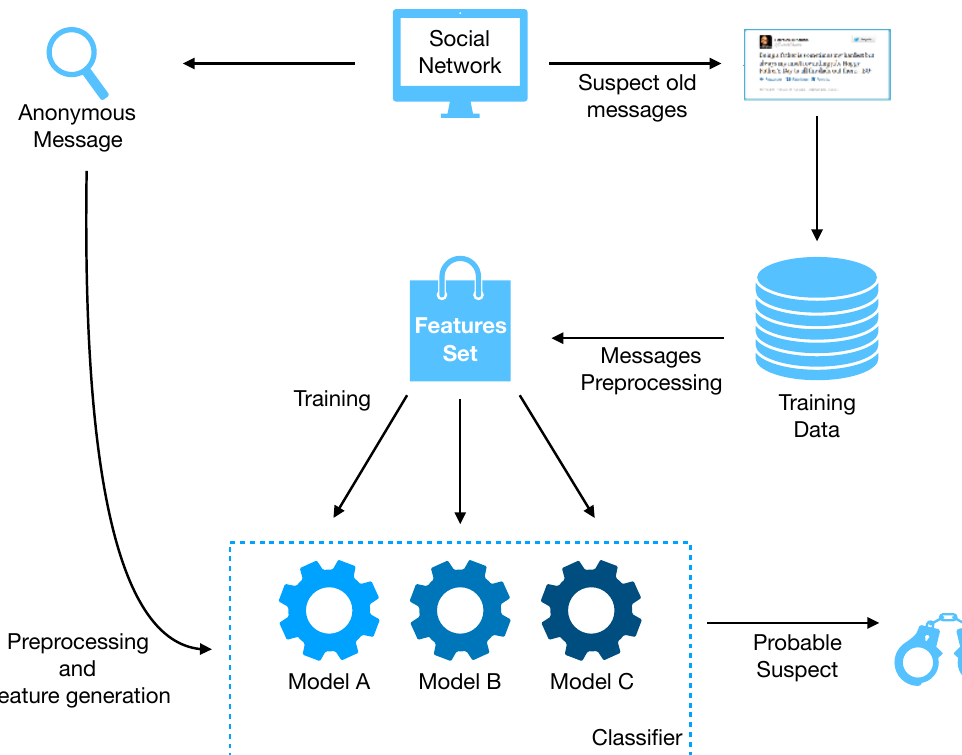
Figure 7 - Overview of the method proposed by Rocha et al. (2017) for authorship attribution of very short messages online. Adapted from (Rocha et al.